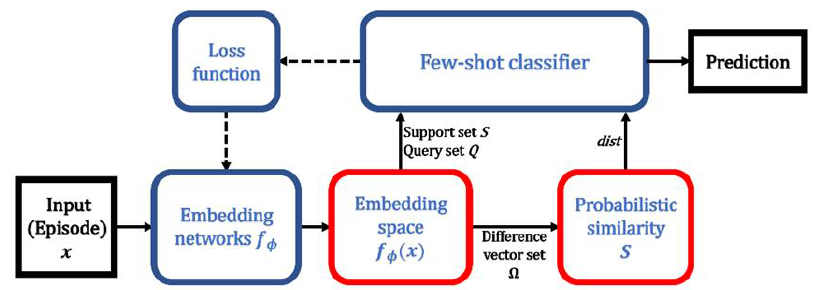
Figure 2. The overall structure of the proposed few-shot classification model.